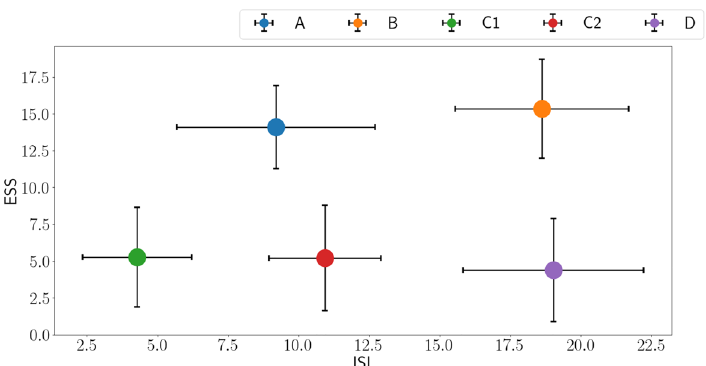
Figure 3. Distribution error bar plots with one σ deviation.